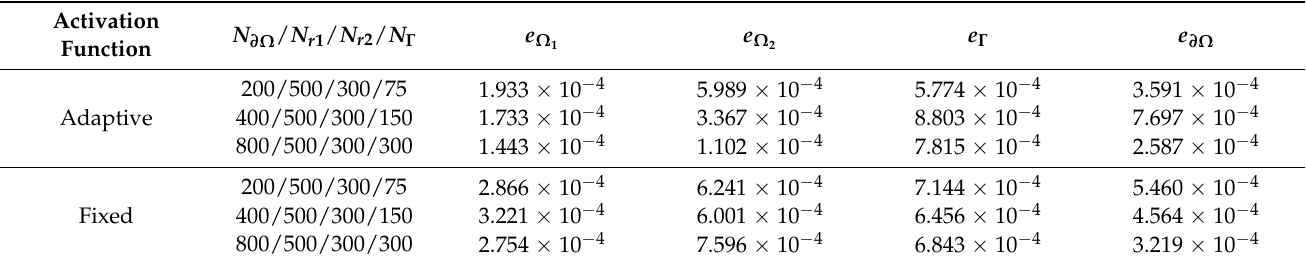
Table 7. Comparison of errors by adaptive and fixed activation function strategies with different numbers of training points for Example 4.